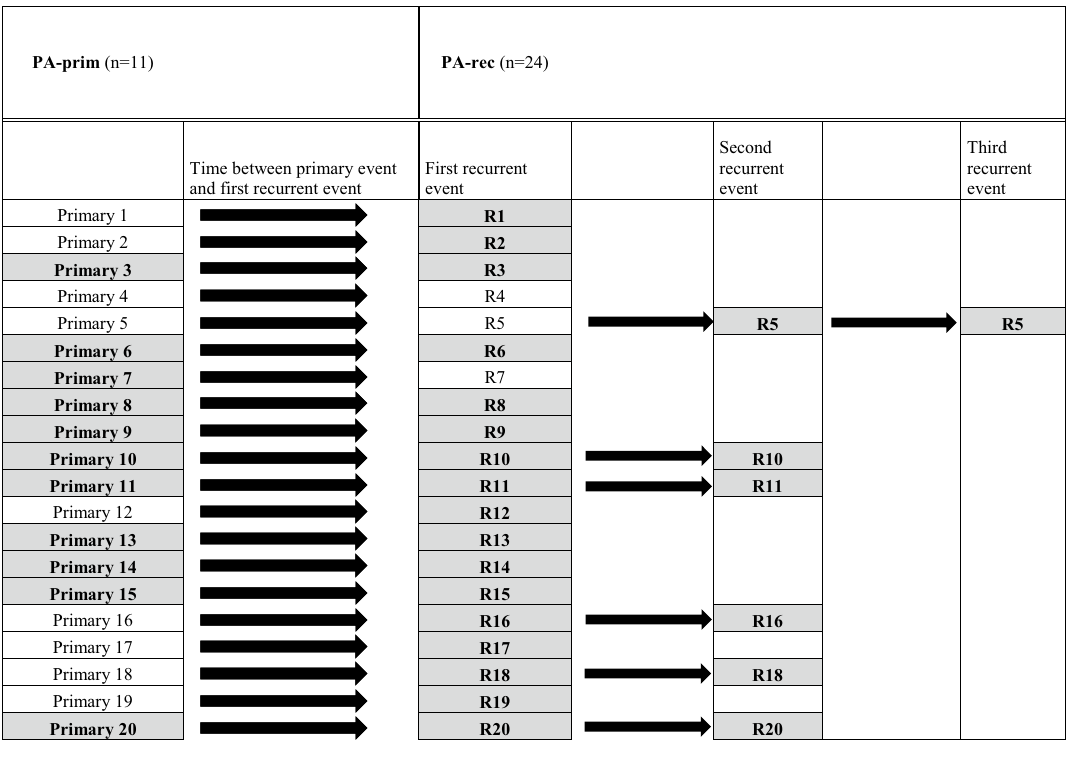
Table 1. Formation of the subgroups of RPA patients, n = 20. The number represents individual patients, n = 20. Available tumor blocks are highlighted in gray/bolded, and these formed the final study population. PA-prim = Primary tumors of RPA patients. PA-rec = Recurrent tumors of RPA patients.